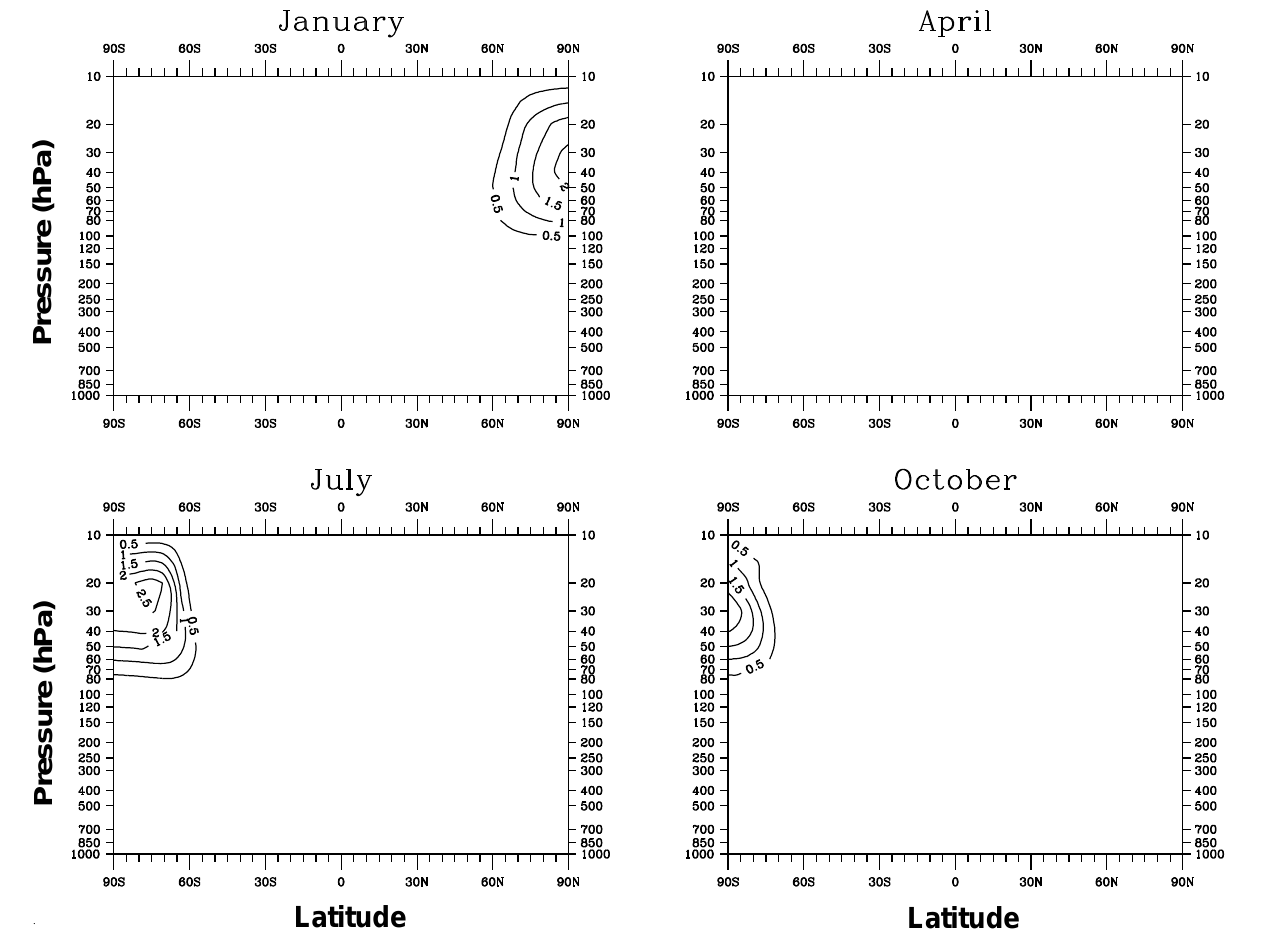
Fig. 15. Climatological monthly and zonal mean modeled ClO x mixing ratios (ppbv) for January, April, July, and